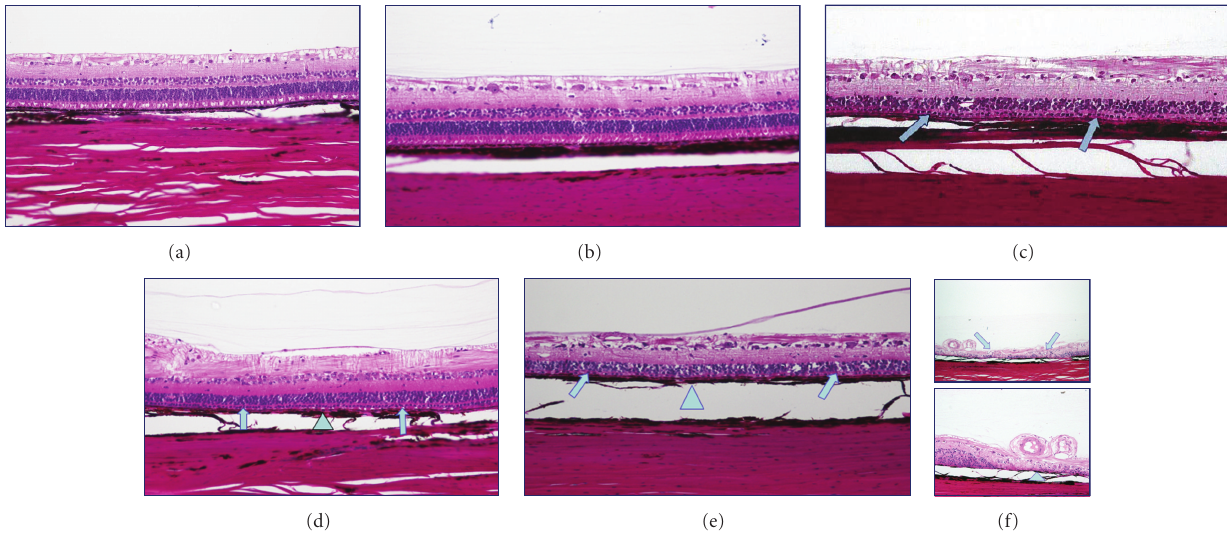
Figure 5: Retinal, RPE, and choroidal histological changes in all dosage groups through the target lesion site. (a) Control, (b) 16 Gy, and (c) 24Gy demonstrate no discernible retinal, RPE, or choroidal changes. (d) 42 Gy shows a broad based lesion with photoreceptor, outer nuclear layer atrophy (arrow), and mild to moderate RPE damage (triangle). (e) 60 Gy shows a more impressive lesion with loss of photoreceptors and outer nuclear layer attenuation (arrow) and moderate RPE attenuation (triangle). (f) 90Gy demonstrates distinct areas of damage involving the entire thickness of the retina (arrow) with RPE and choroidal disruption (triangle). Table 1: IRay Treatment Dosing Schema of Yucatan